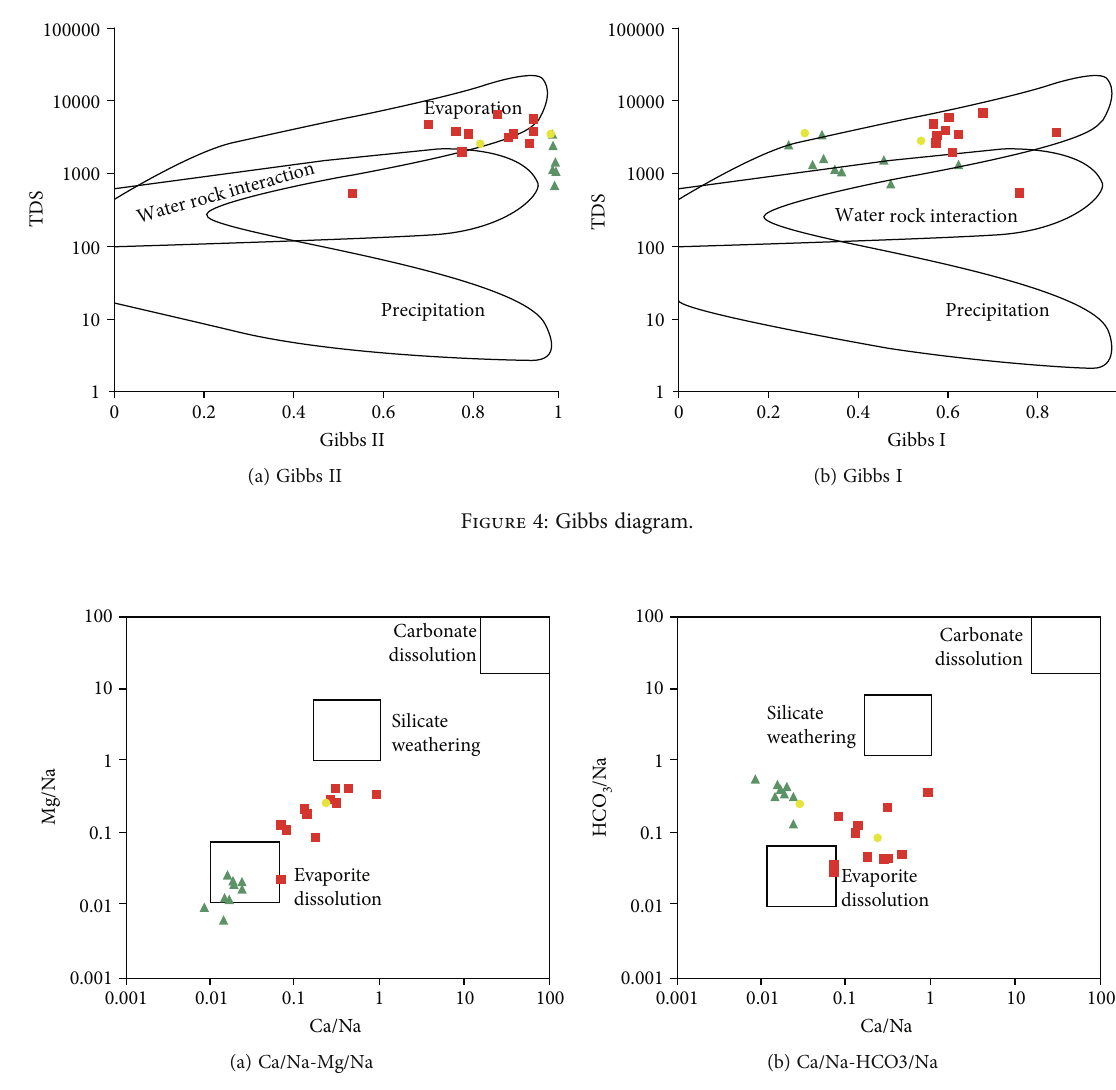
Figure 5: The ratio of Ca/Na-Mg/Na and